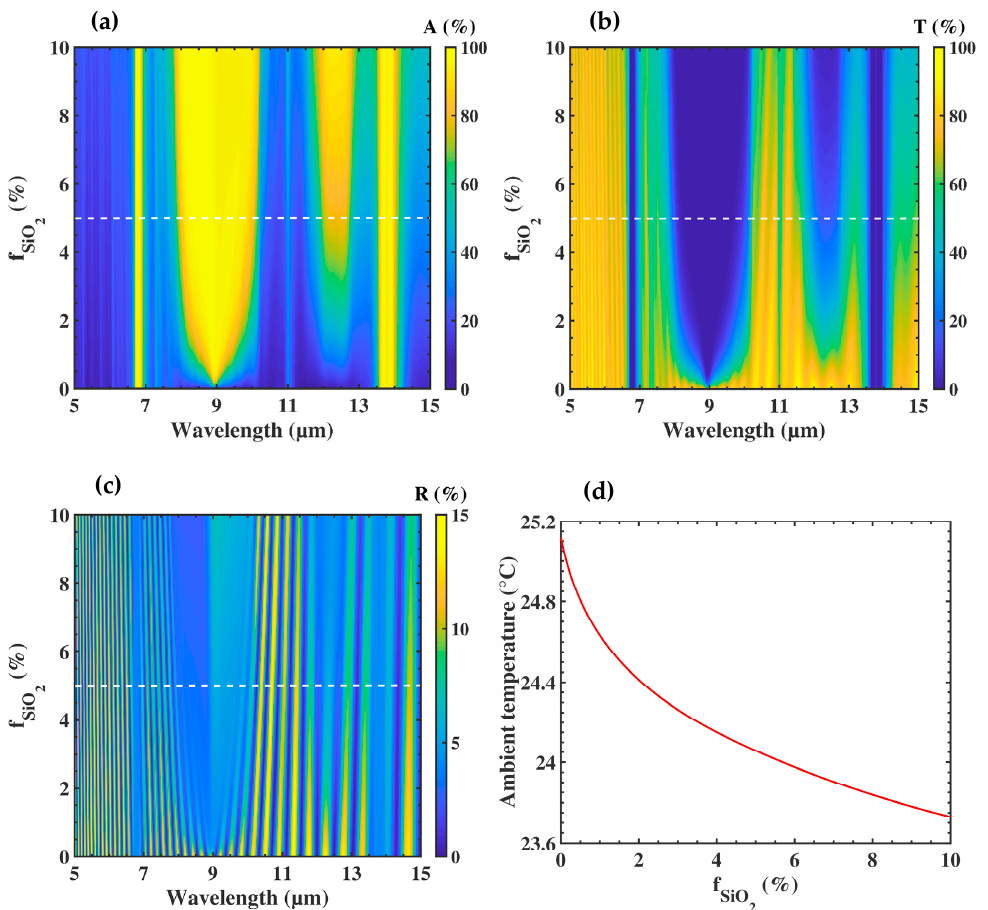
Figure 3. Evolution of ( a ) the absorption (A), ( b ) transmission (T), and ( c ) reflection (R), as a function of the volume fraction of SiO 2 submicron particles over the wavelength 5–15 µ m. ( d ) Evolution of the ambient temperature required by the skin to achieve T s = 34 ◦ C, as a function of the volume fraction of SiO 2 submicron particles.